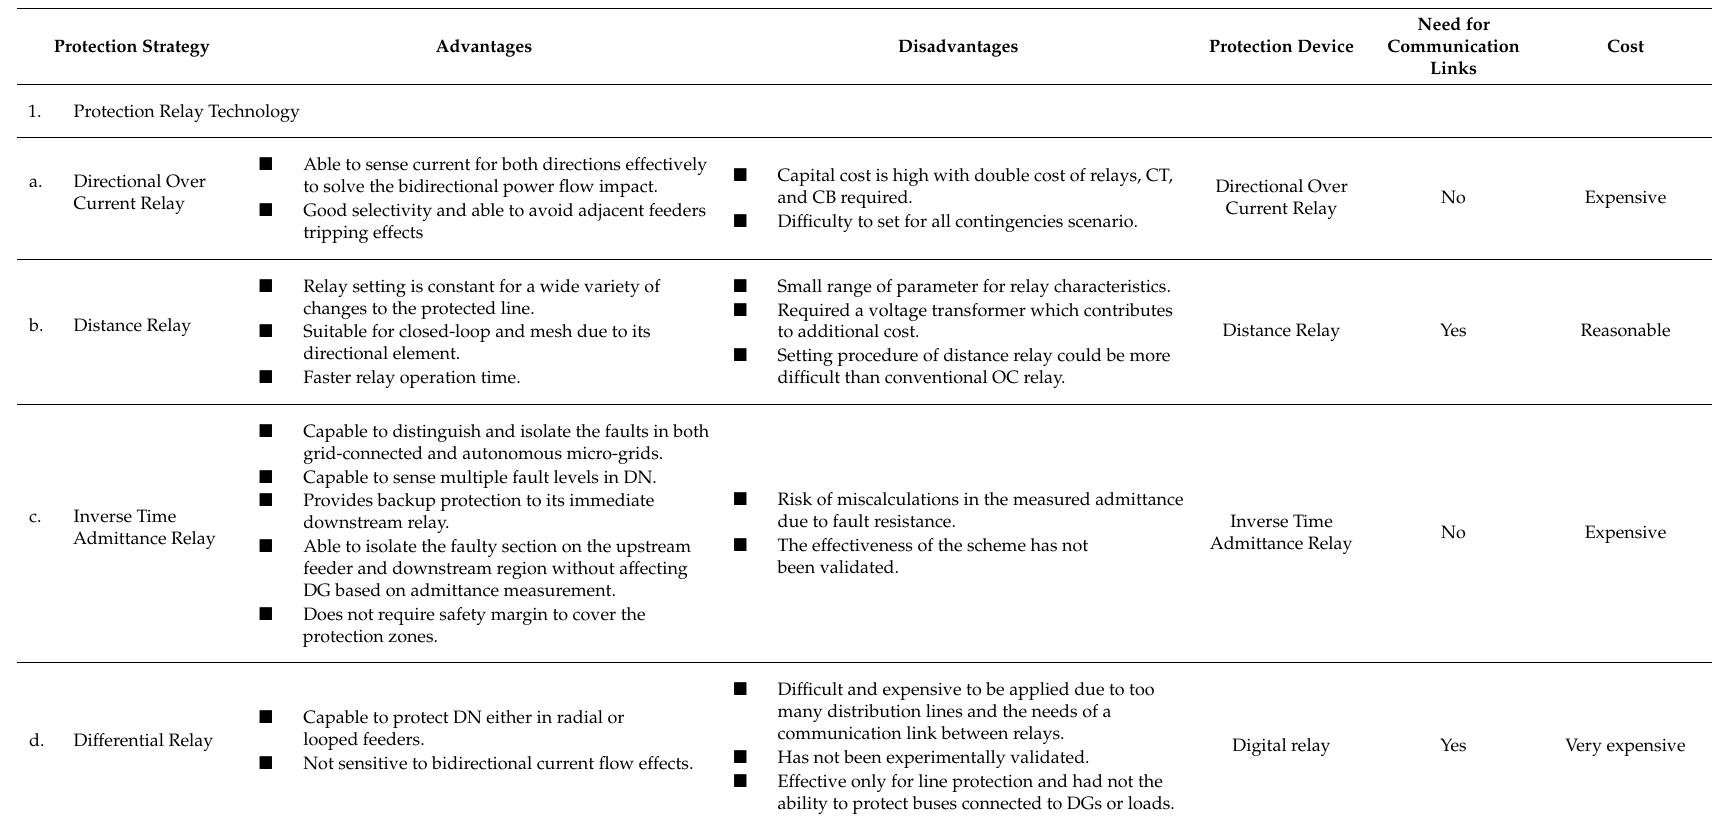
Table 4. Comparison of protection strategies for modified DN connected with